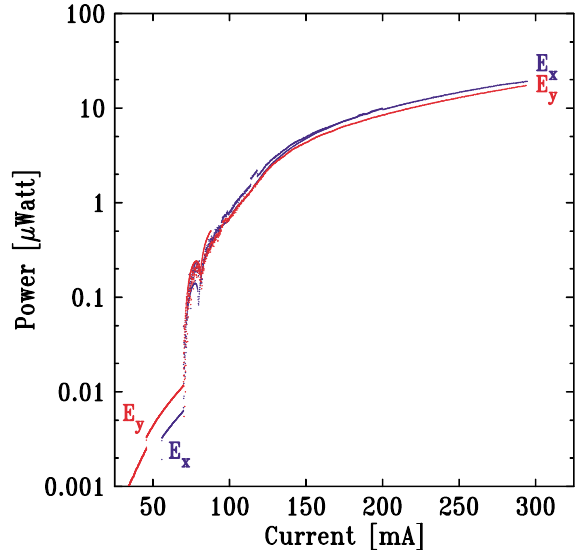
radiation.FIG. 4. (Color) Measured average power in A and C peaks versus bunch current. The curves show the calculated total ISR power (solid line) and a quadratic fit (dashed line) to the high current A peak